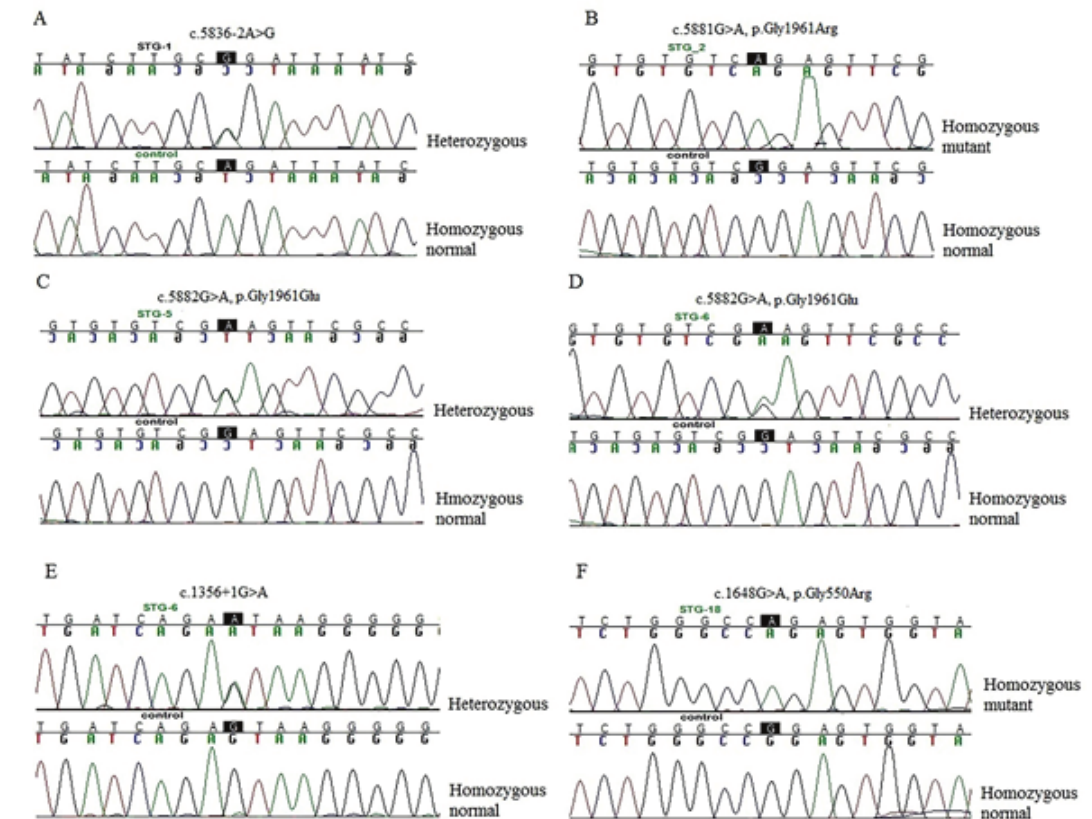
Figure 2. Sequence chromatograms of five mutations observed among the Stargardt disease-affected patients studied. (A) c.5836-2A > G in patient STG-1; (B) c.5881G > A mutation in patient STG-2; (C) c.5882G > A mutation in patient STG-5 and STG- 6; (D) mutation c.1356+1G > A in patient STG-6; and (E) mutation c.1648G > A in patient